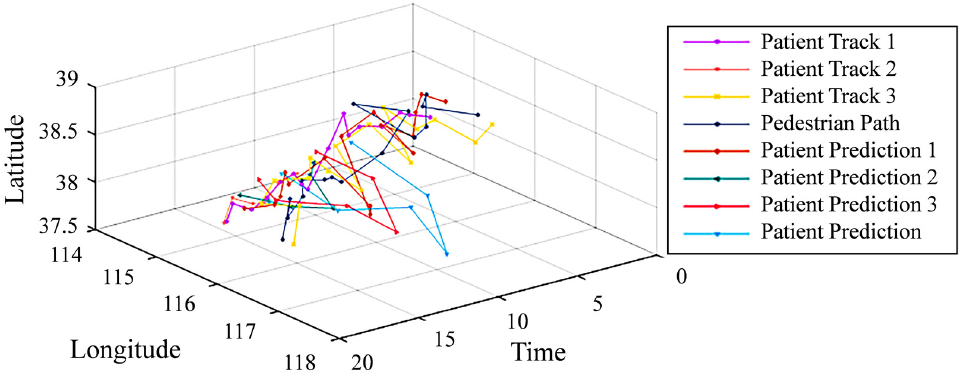
Figure 14. Track crossing diagram.